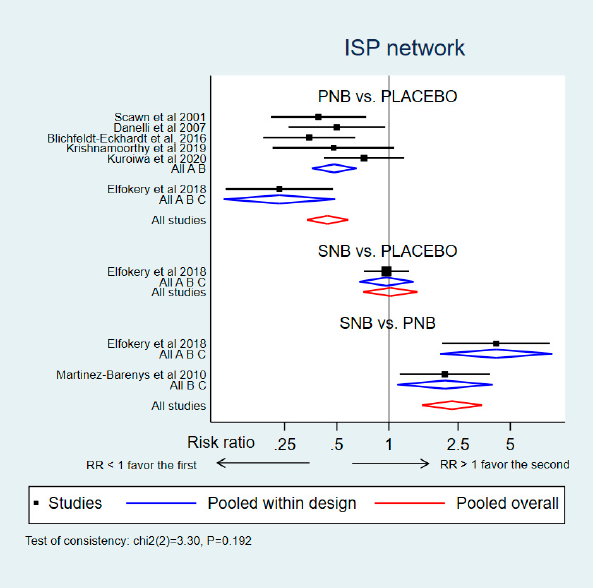
Figure 6. Network meta-analysis results for ISP prevention during 24 h after surgery. PNB is associated with lower risk of ISP than placebo and SNB. Forest plot: RR < 1 indicated that the first treatment in pairwise comparison is associated with lower risks of ISP; thus, the first treatment was favored compared to the second. While RR > 1 indicated that the first treatment in pairwise comparison is associated with increased risks of ISP; the second treatment was favored compared to the first. ISP, ipsilateral shoulder pain; RR, risk ratio; PNB, phrenic nerve block; SNB, suprascapular nerve block